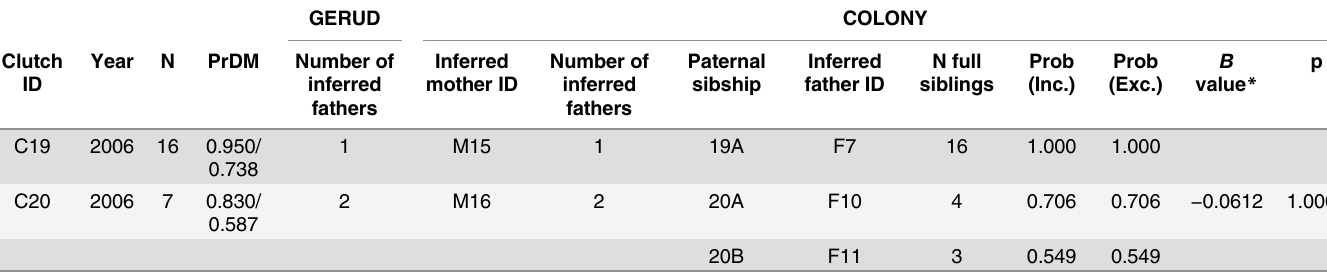
PLOS ONE | DOI:10.1371/journal.pone.0150245 March 16,